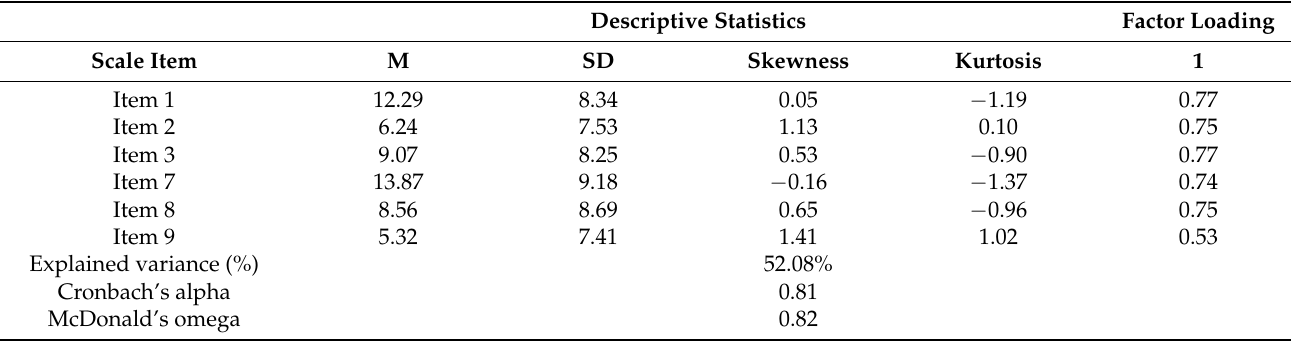
Table 3. Descriptive statistics of Stress of Conscience Questionnaire